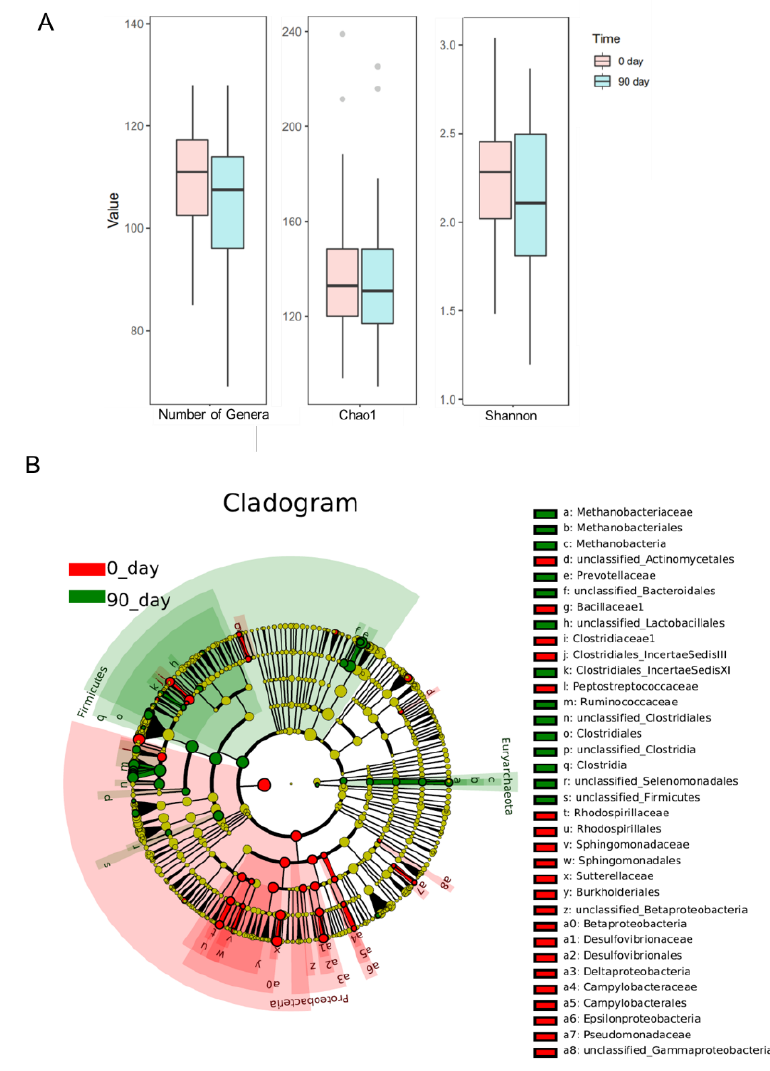
Figure 4. The richness (number of genera) and diversity (Chao1 and Shannon indexes) of gut microbiota ( A ). The structure of the microbiota is presented in the cladograms ( B ), the circle radiated inside-out represents the classification of taxa level from phylum to family. Each small circle at different classification levels represents a taxon and the diameter of the small circle is proportional to the relative abundance. The taxa not with significant differences were colored by yellow and significantly different taxa were colored by different groups, the taxa marked with red color were enriched in the baseline. n = 48, each group.